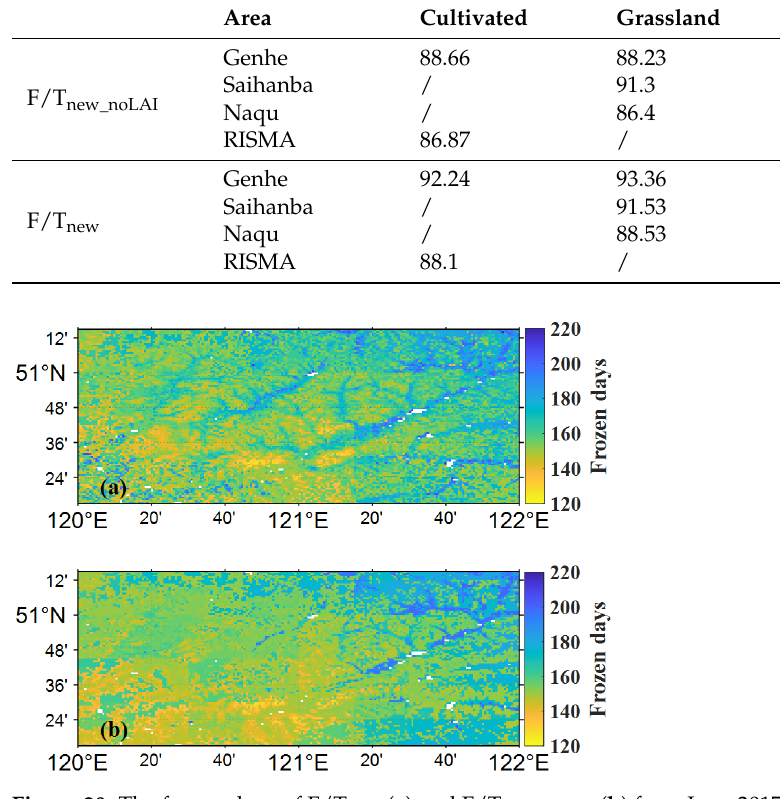
Figure 19. A comparison of thawed ( a ), frozen ( b ) and total ( c ) accuracies between F/T new and F/T new_noLAI .